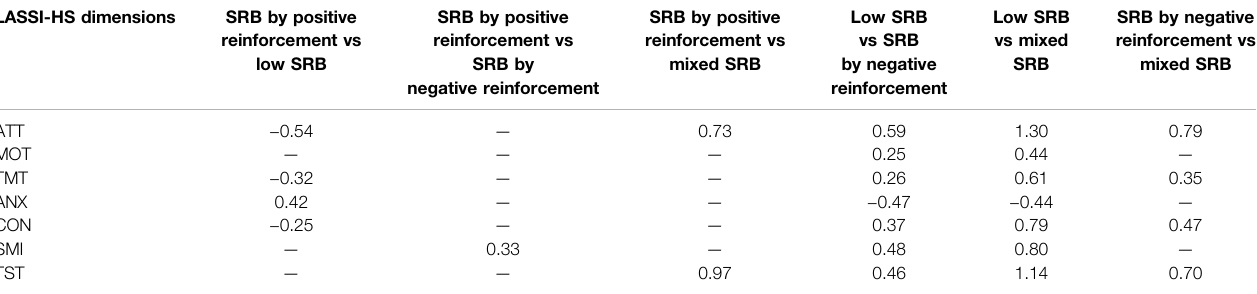
TABLE 3 | Cohen ’ s d value for post hoc contrasts between pro fi les on LASSI-HS dimensions . LASSI-HS dimensions SRB by positive reinforcement